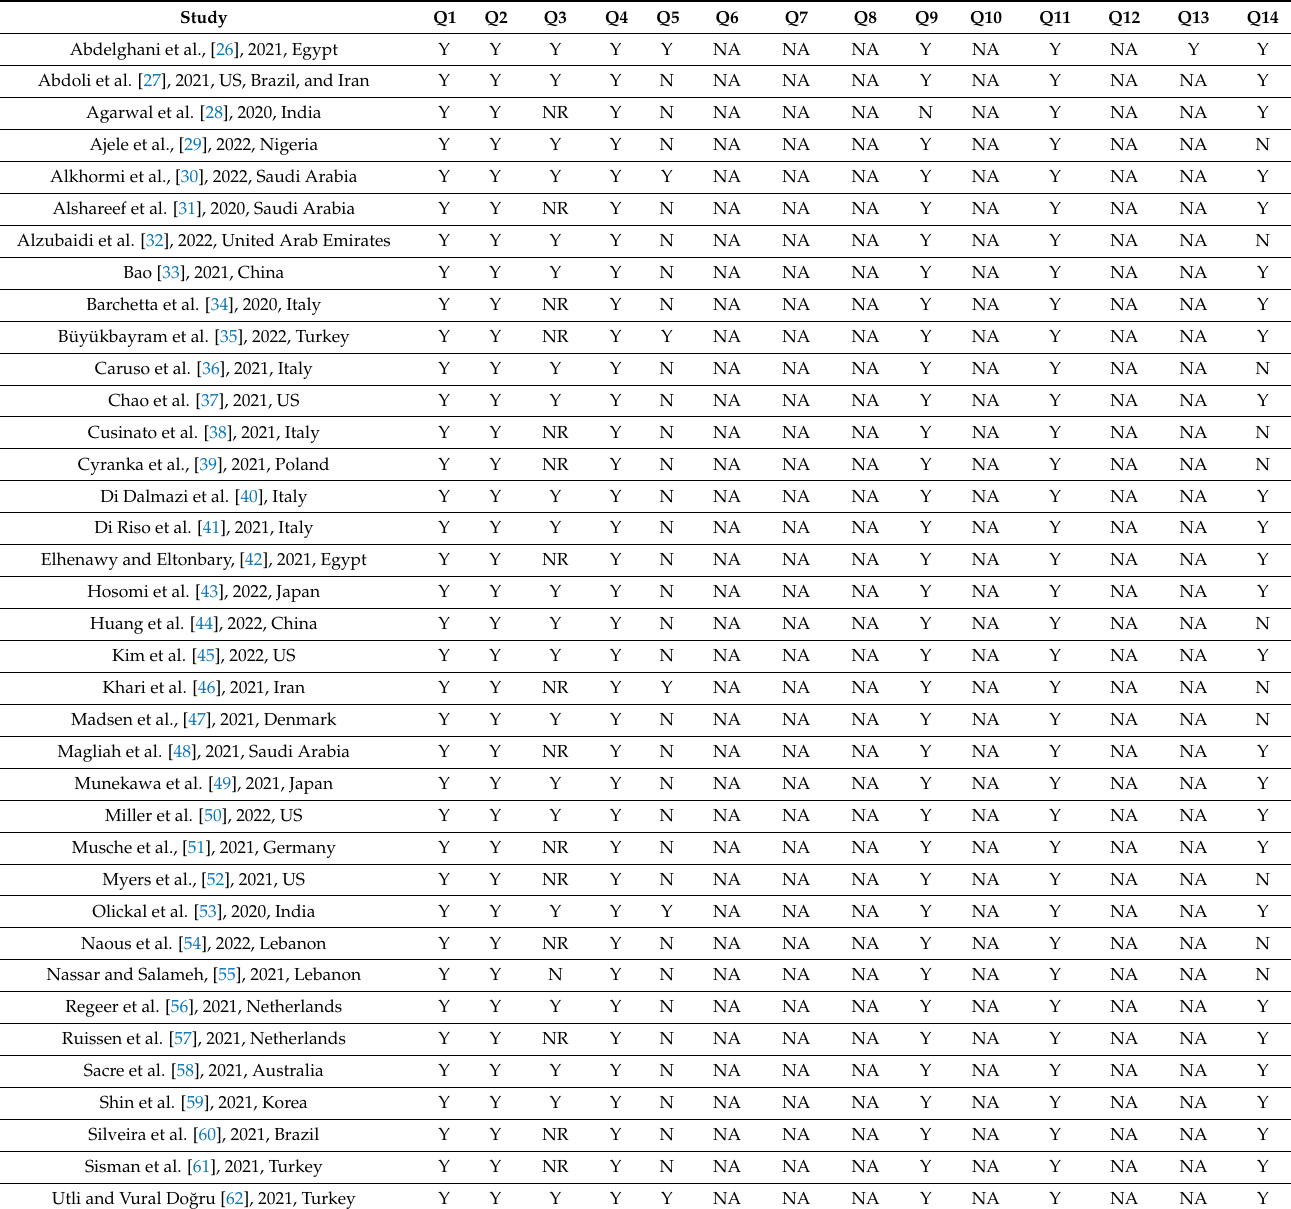
Table A1. Observational studies quality assessment with National Heart, Lung, and Blood